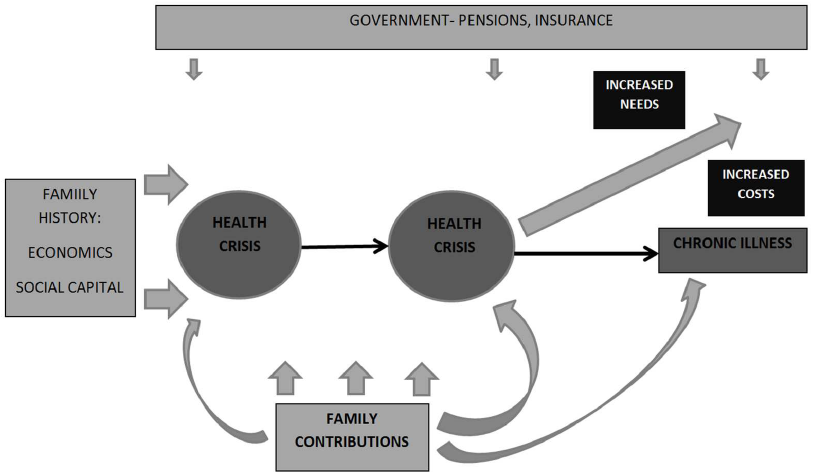
Fig 1. Trajectories and costs of caring for a dependent older